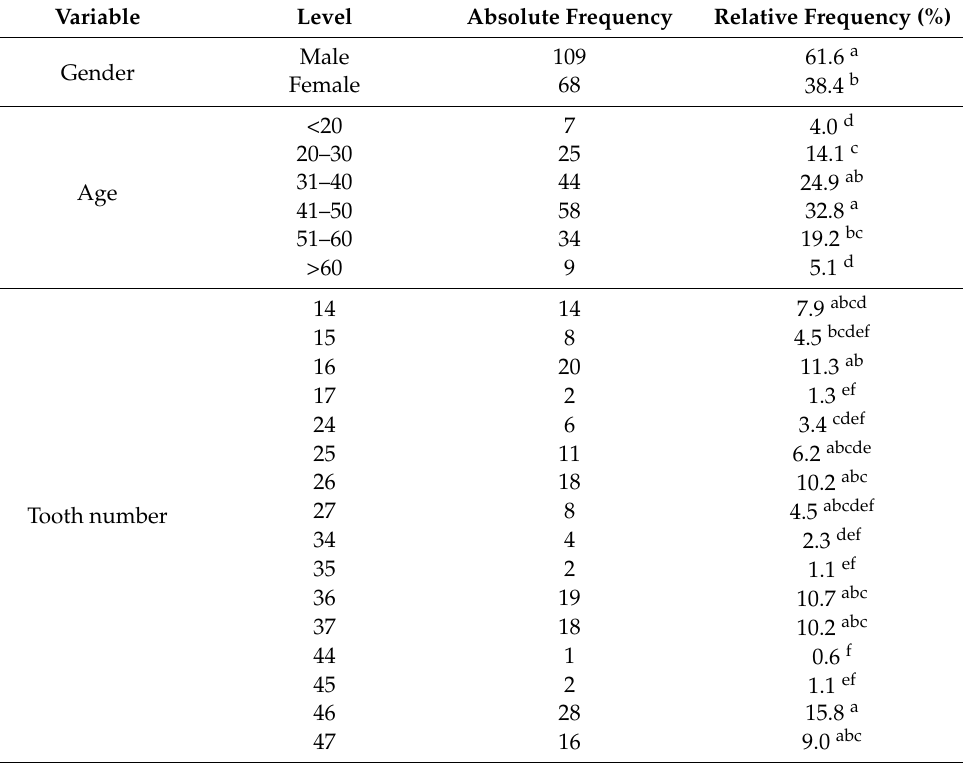
Table 1. Absolute and relative frequency of general variables of